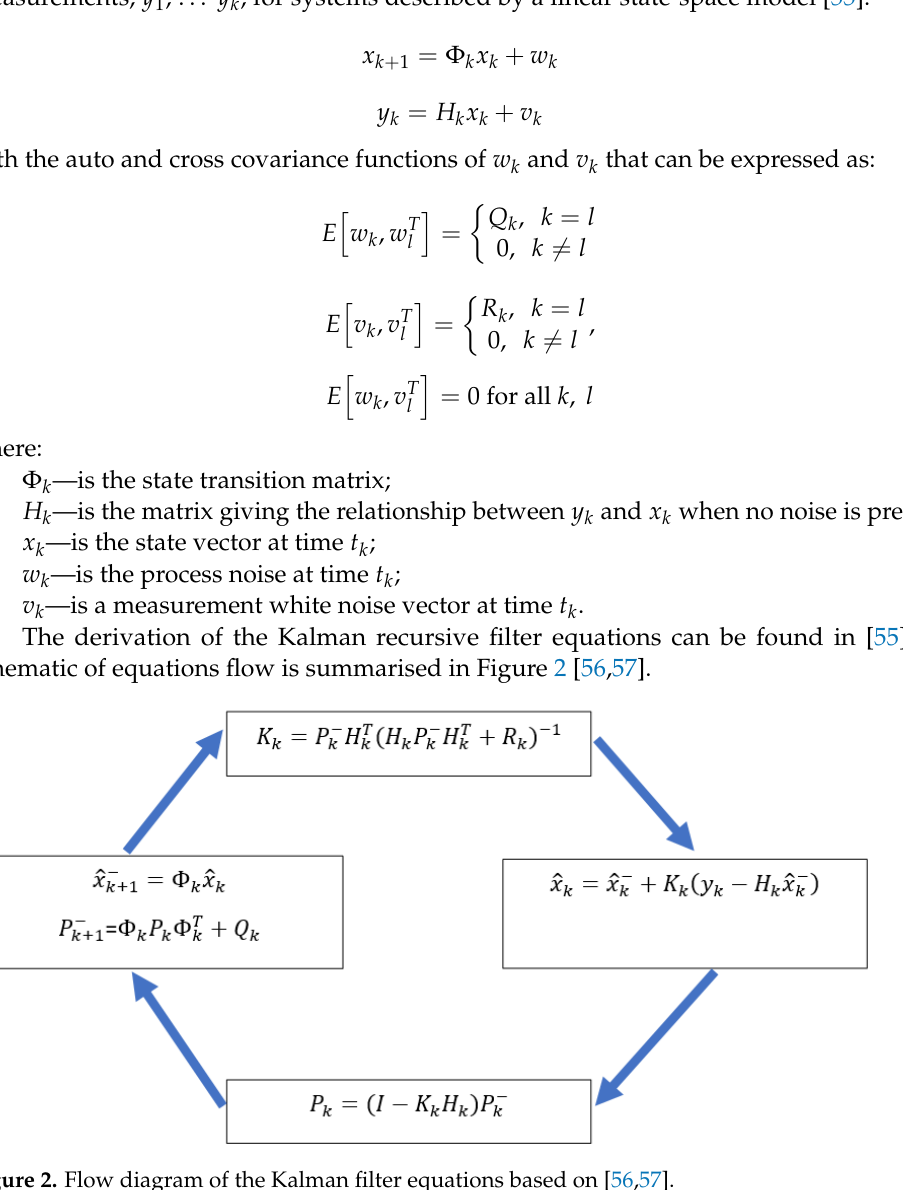
Figure 2. Flow diagram of the Kalman filter equations based on [56,57].